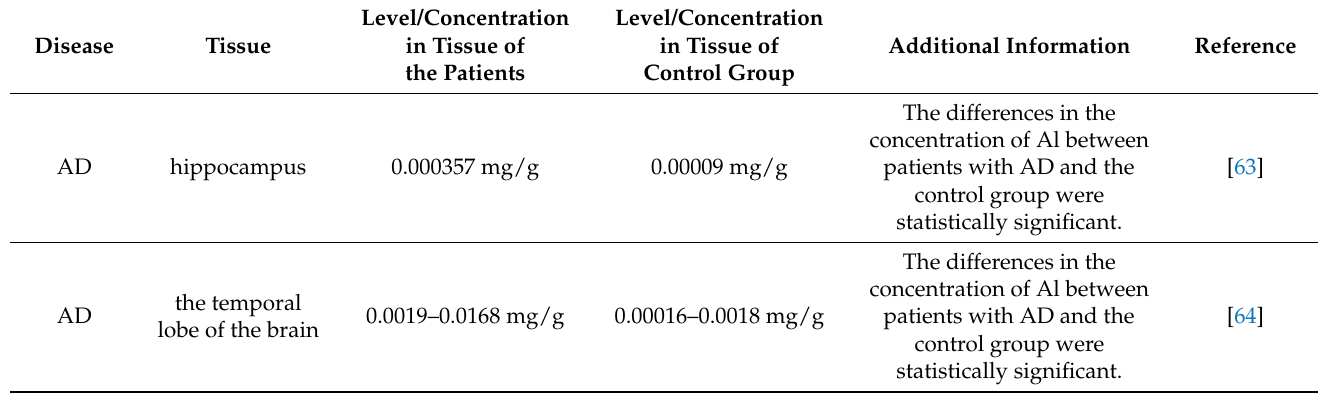
Table 4. The concentration of aluminium in the tissues of patients with particular neurological